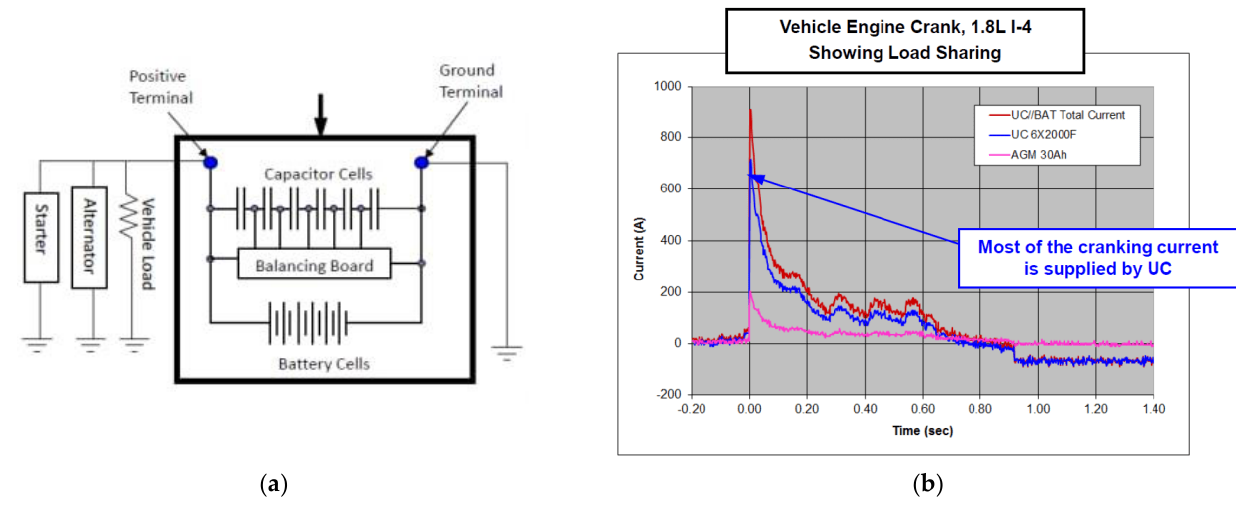
Figure 7. Maxwell-powered voltage stabilization system (VSS) ( a ) capacitor and battery setup, ( b ) performances characteristics [47].